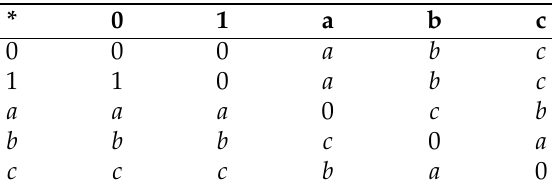
Table 7. Cayley table for the binary operation “ ∗ ”.